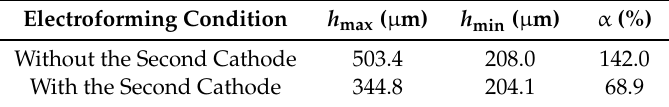
Table 7. Nonuniformity α of the microfluidic chip